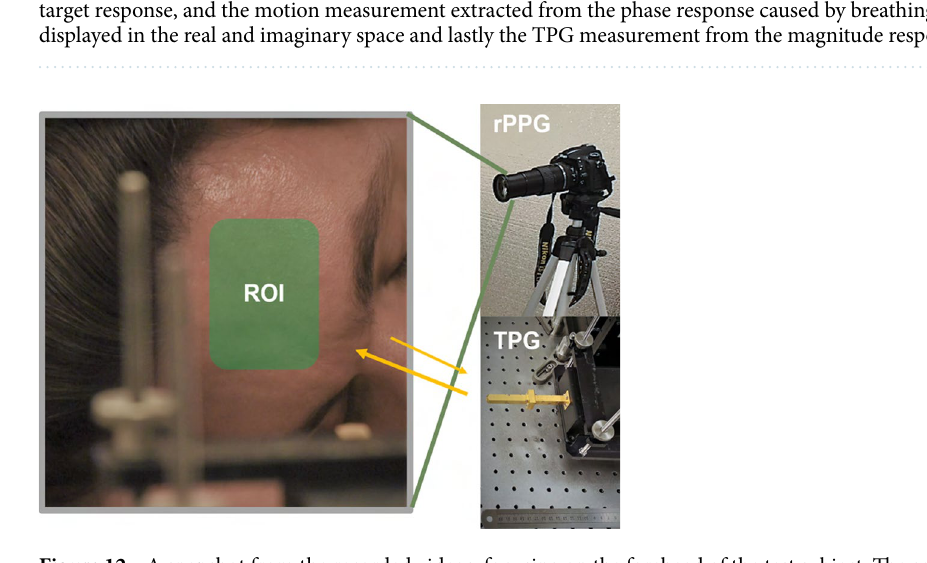
Figure 12. A snapshot from the recorded videos, focusing on the forehead of the test subject. The green colored area in the left figure is the manually selected area to extract rPPG signals from the sequence of image frames. rPPG measurement and TPG measurement setups are displayed in the right figure. The camera is placed about 2 m away from the subject but zoomed in to focus at the human forehead area. The THz transceiver is placed about 30 cm away from the subject. (Informed consent is obtained from this test subject for publication of identifying